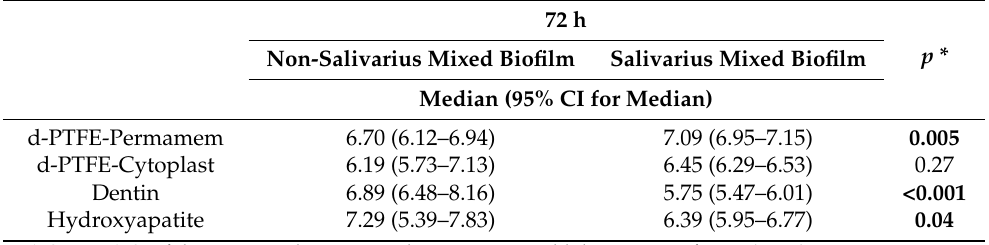
Table 1. Comparison of the total number of bacteria (log CFU/mL) in a 72-h mixed biofilm.